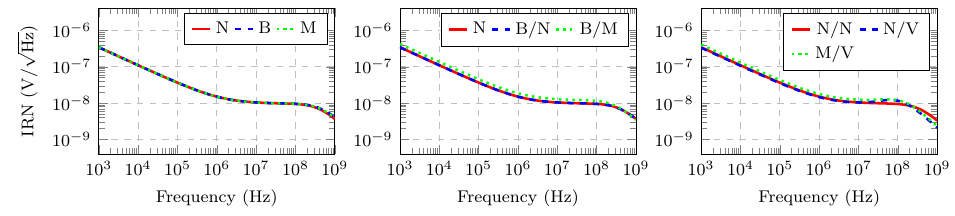
Figure 18. Noise simulation results.